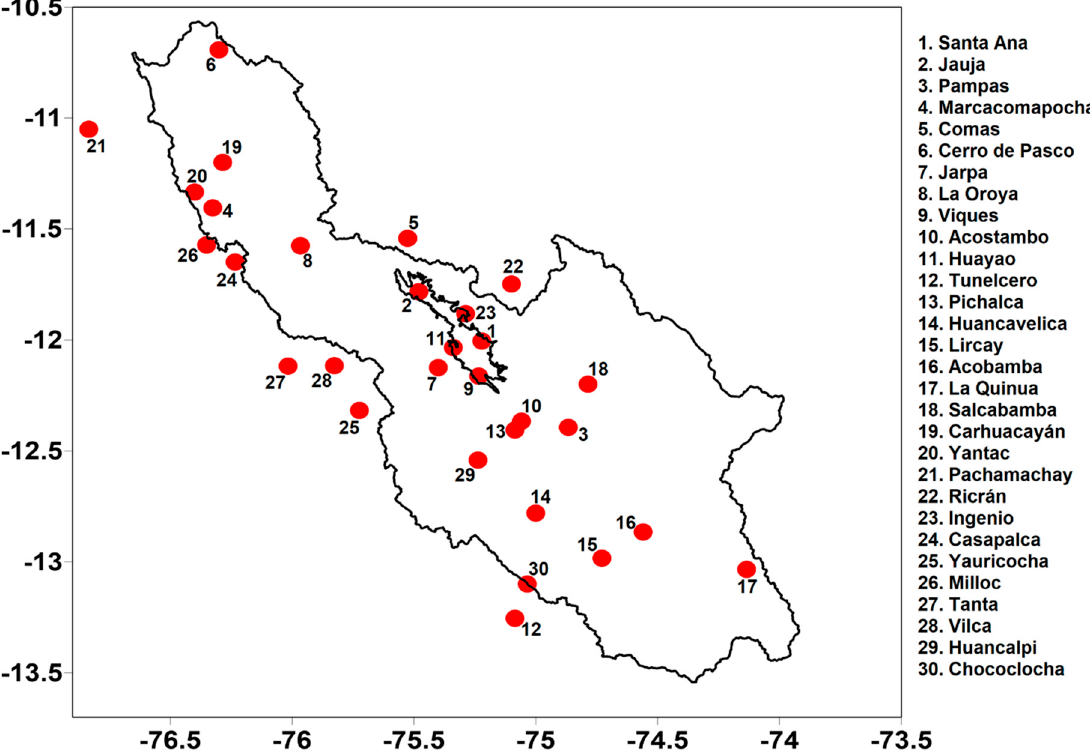
Figure 1. Spatial distribution of the observation network stations. Table 1. Dates of cases of extreme rainfall selected for the study. Fechas